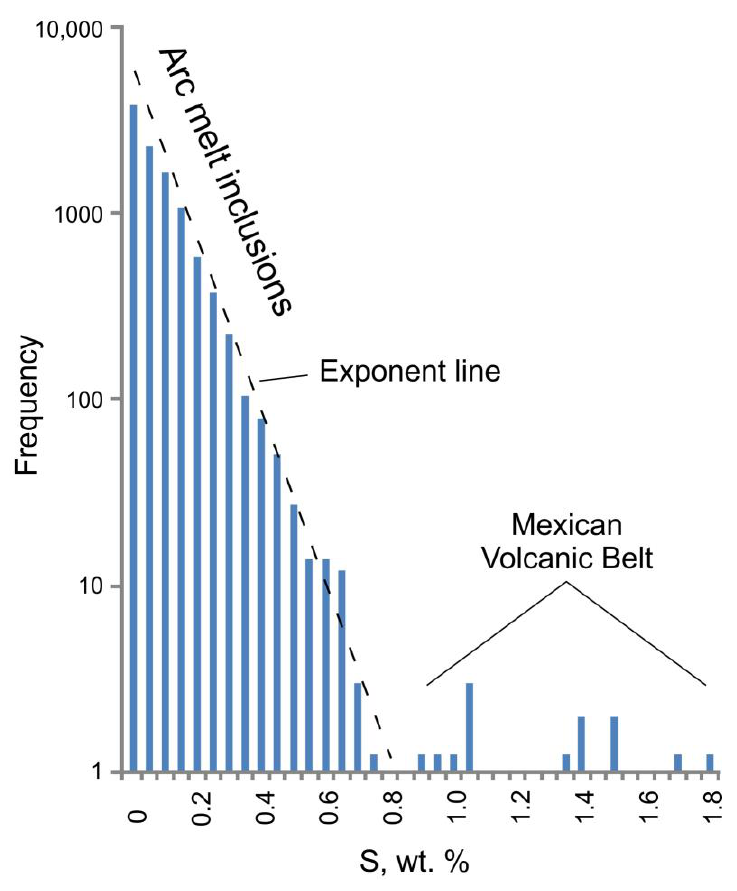
Figure 9. Histogram showing the statistical distribution of sulfur concentrations in melt inclusions from island-arc volcanoes worldwide (without new data on Tolbachik). There is an exponential increase in low S concentrations, aside from alkaline rocks of the Western Mexican Volcanic Belt [15].